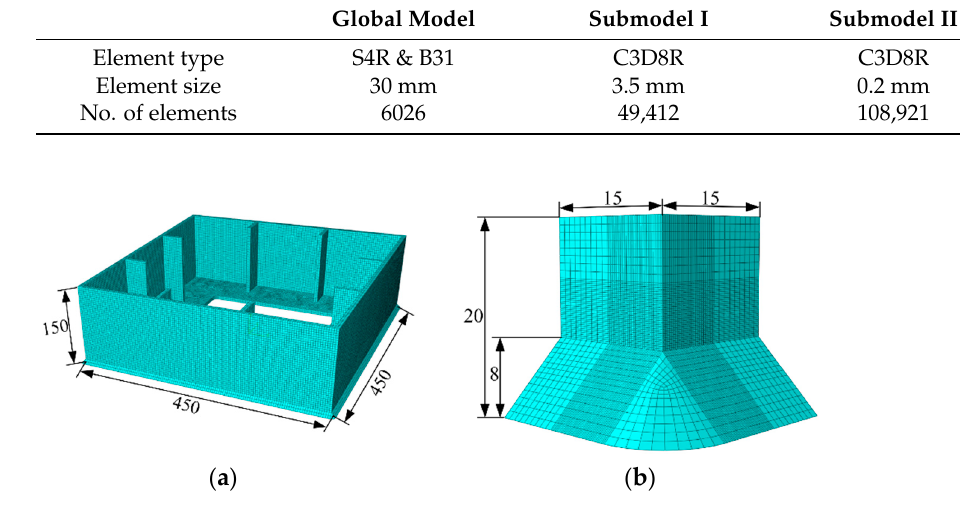
Figure 4. Mesh and submodels: ( a ) Sub-model I (unit: mm); ( b ) sub-model II (unit: mm). Table 4. Griding partition details of global model and submodel I. Table 3. Summary of meshing information.